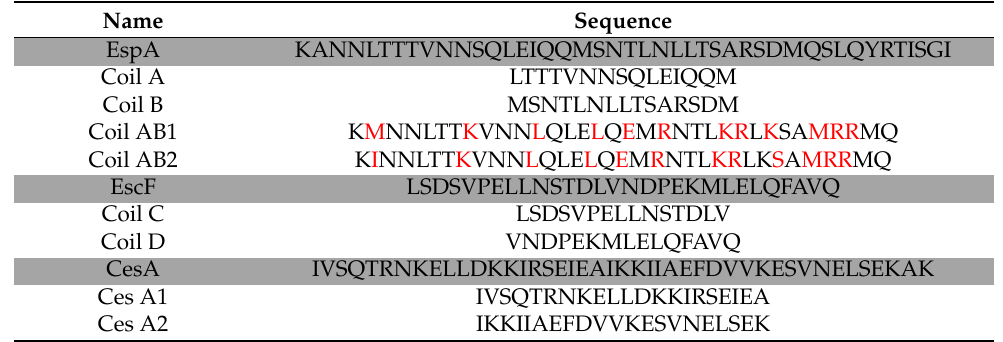
Table 1. Sequences of effectors and synthesized coiled-coil peptides. Red residues were changed to increase solubility. Greyed sequences are original to the protein.